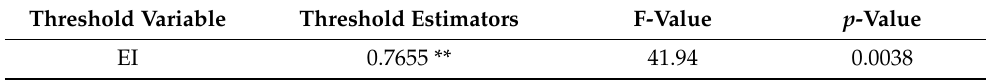
Table 2. Threshold effect test results.